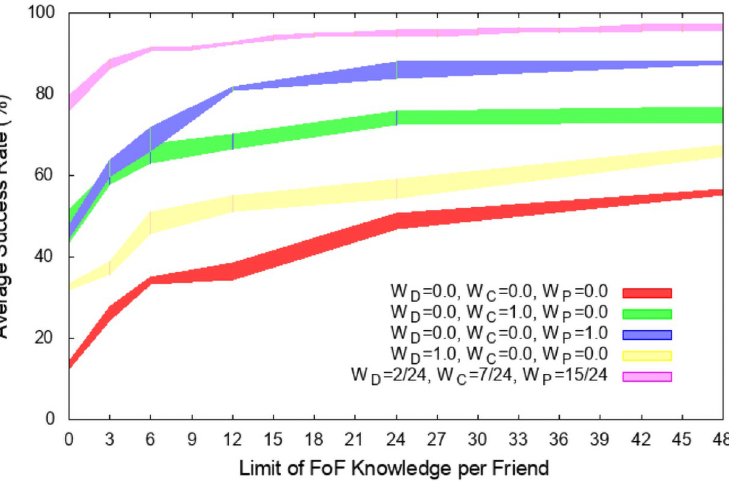
Fig 1. Success rates with error bars collected from 500 runsfor each of the five selections of search weights defined in Eq 1 with different seeds for the random number generator for each of 500 distinct pairs of starting and target nodes selected to be at least 1,609 km apart. The plots include the baseline random search with all metric weights set to 0, three searches using a single metric with weight 1, and the search with the metric weights yielding the highest performance. We plot each rate as a function of the maximum number of i-friends of which a node is aware for each of its friends. The error bars show the standard error.